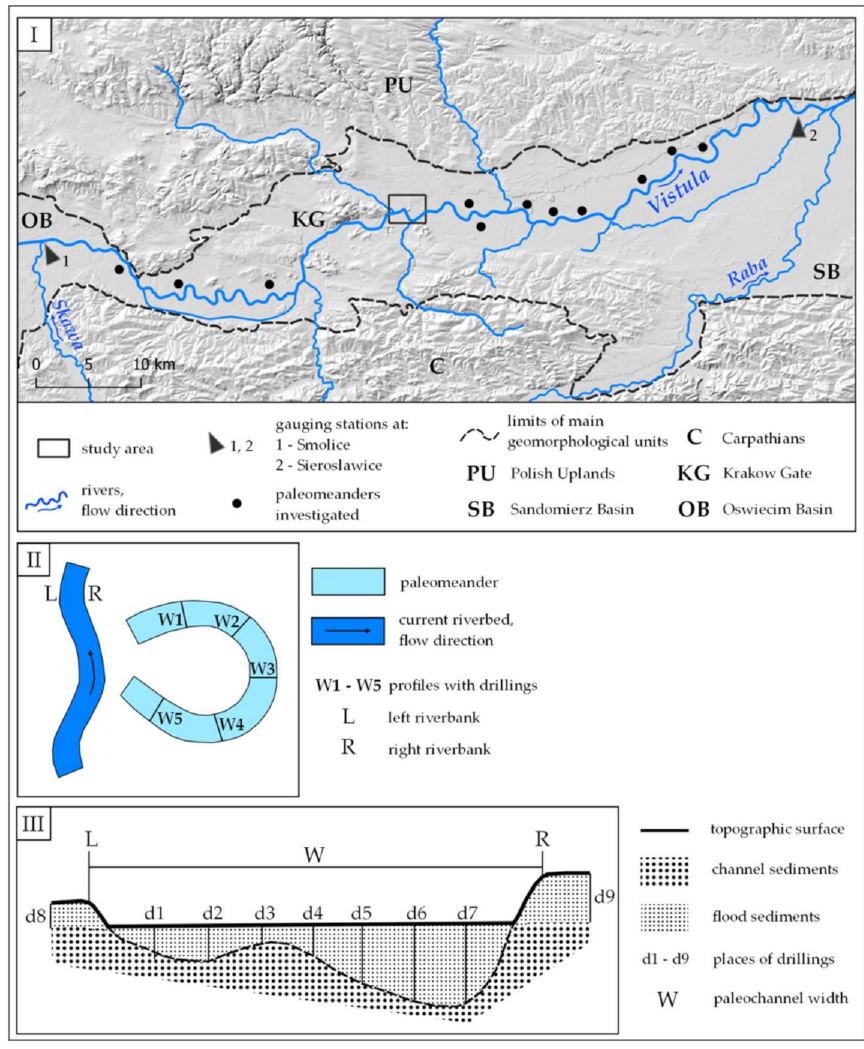
Figure 4. Location of the investigated paleomeanders of the Vistula river near Krakow ( I ) and distribution of sites ( II , III ) where drillings were carried out in order to determine parameters of the paleochannel [33,57]. Explanations in the